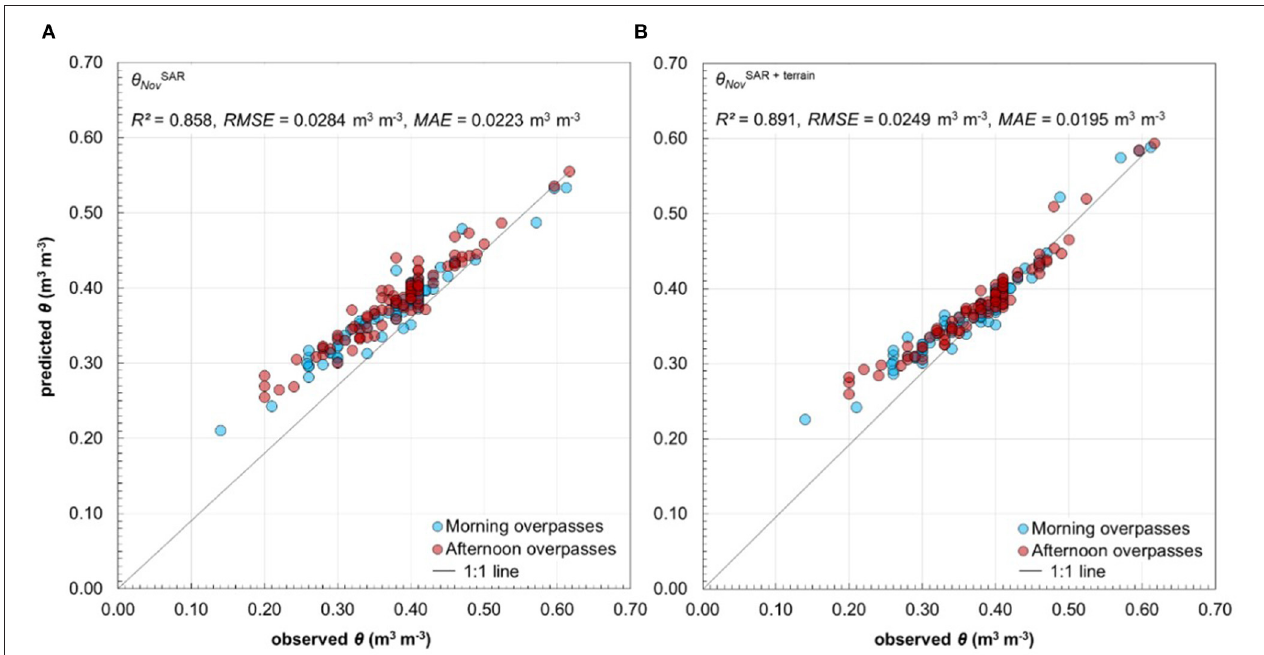
FIGURE 2 | Observed vs. predicted near-surface soil moisture ( θ , m 3 m − 3 ) in Nov. 2018 using the model based on (A) SAR parameters only ( θ NovSAR ) and (B) SAR and terrain parameters combined ( θ NovSAR + Terrain ). The different coloring only serves to visualize the differences between the morning (blue dots) and the afternoon (red dots). The regression models, however, were run over the entirety of the observation points ( n =